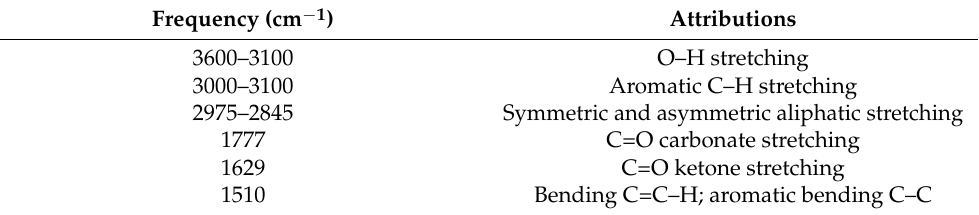
Figure 9. IR spectra of THCM and THCM-PC polymer. Table 1. Attribution of signals relating to the IR spectra in the Figure 8. Table 2. Attribution of signals relating to the IR spectra in the Figure 9.